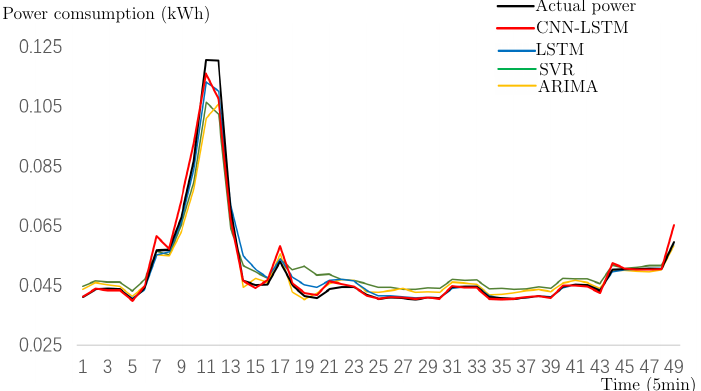
Figure 5. The prediction results for household 3 power consumption data.